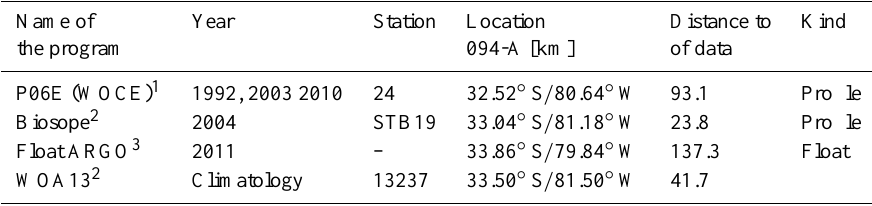
Table 1. Sources of hydrographic data used in this study. The name, location, and distance between the nearest location of the measurements and station 094-A are reported.